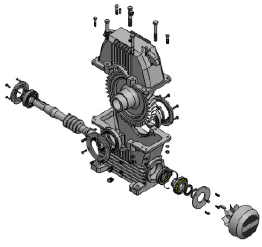
Figure 11. ( a ) Gearbox assembly;( b ) axonometry of gearbox assembly.